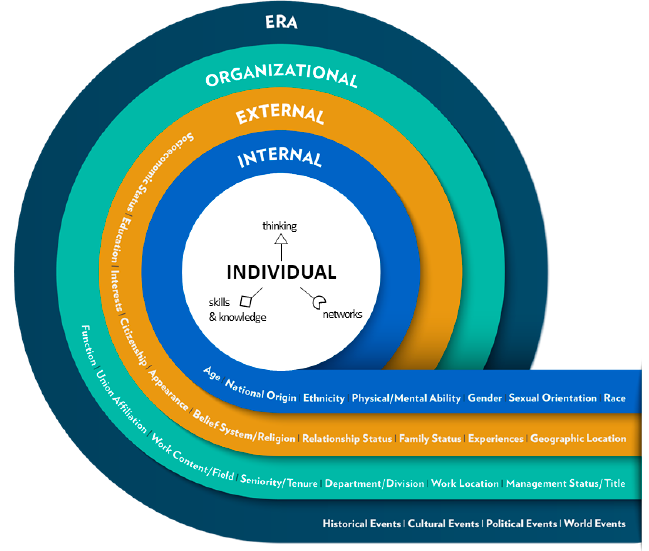
Figure 1. Individual’s talent framework for intersectionality.